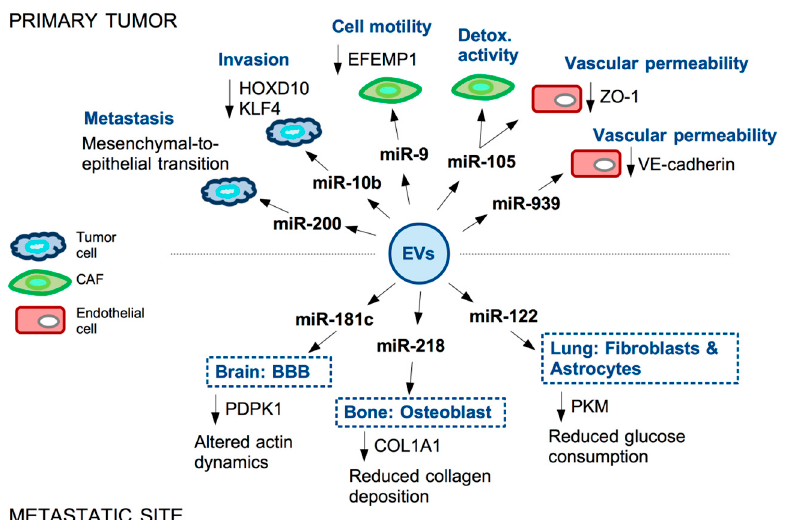
Figure 2. Examples of miRNAs secreted in EVs by TNBC cells and their functional impact in the primary tumor and at metastatic site. microRNAs are secreted by TNBC cells into extracellular vesicles (EVs). These reach recipient cells both in the tumor microenvironment (TME) and, through the bloodstream, in the metastatic niche. miRNAs enclosed in the EVs contribute to tumor progression by affecting motility and metabolism of tumor cells and fibroblasts (CAFs), permeability of the vasculature and stiffness of the TME.